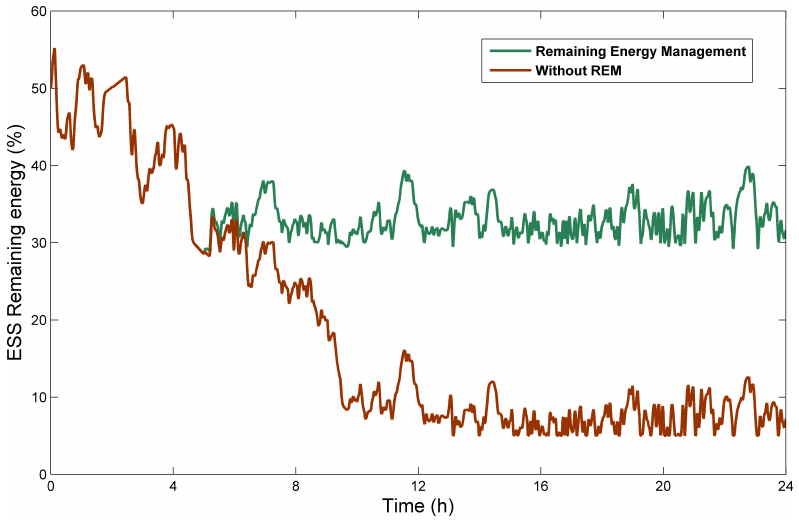
Figure 9. The remaining energy curve with and without remaining energy management